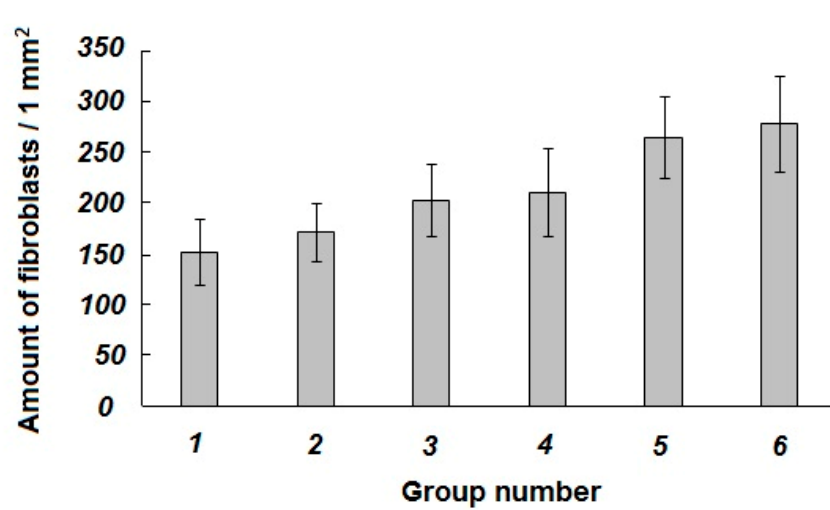
Figure 6. Specific amount of fibroblasts in the Pl. waltl newt’s eye sclera tissue after the 72-h-long organotypic in vitro cultivation of the samples belonging to different reference and experimental Groups.